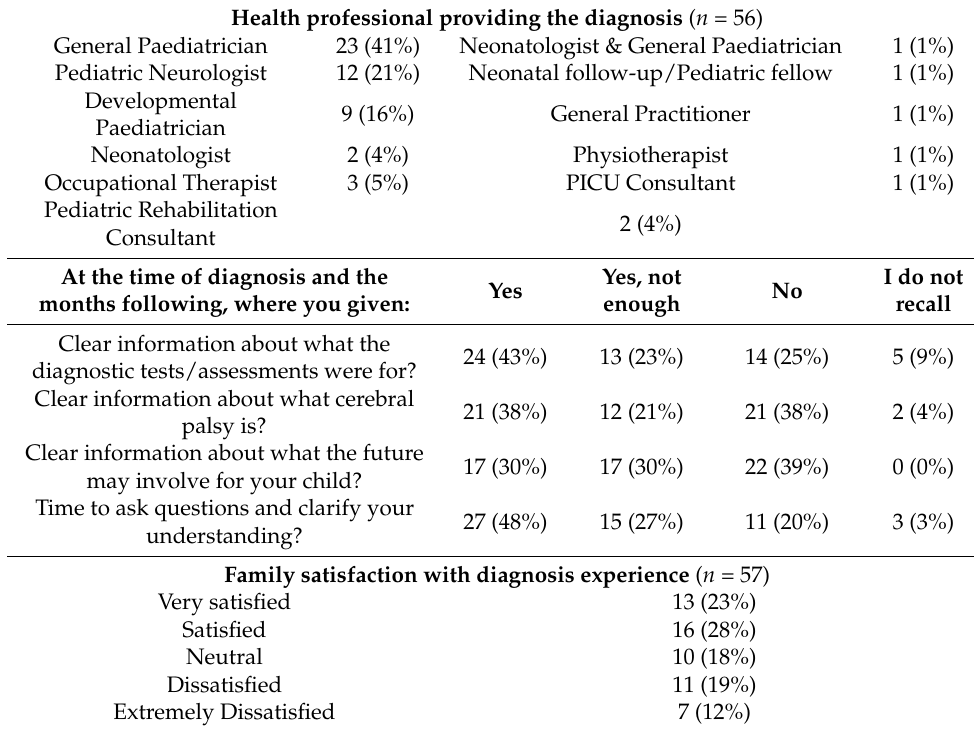
Table 2. Family experience of diagnosis, including who (i.e., which health professional) provided the diagnosis, information provided at the time of diagnosis and the months, and a rating of satisfaction with the delivery. A total ( n ) and percentage is provided for each